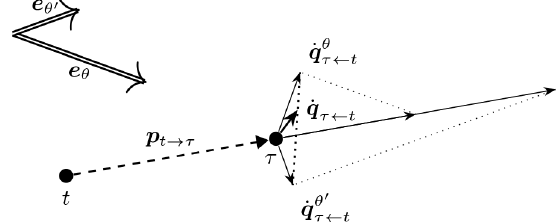
Figure 8. Illustration of how wind-direction-specific push-cross pseudo-gradient vectors combine into an averaged push-cross pseudo-gradient